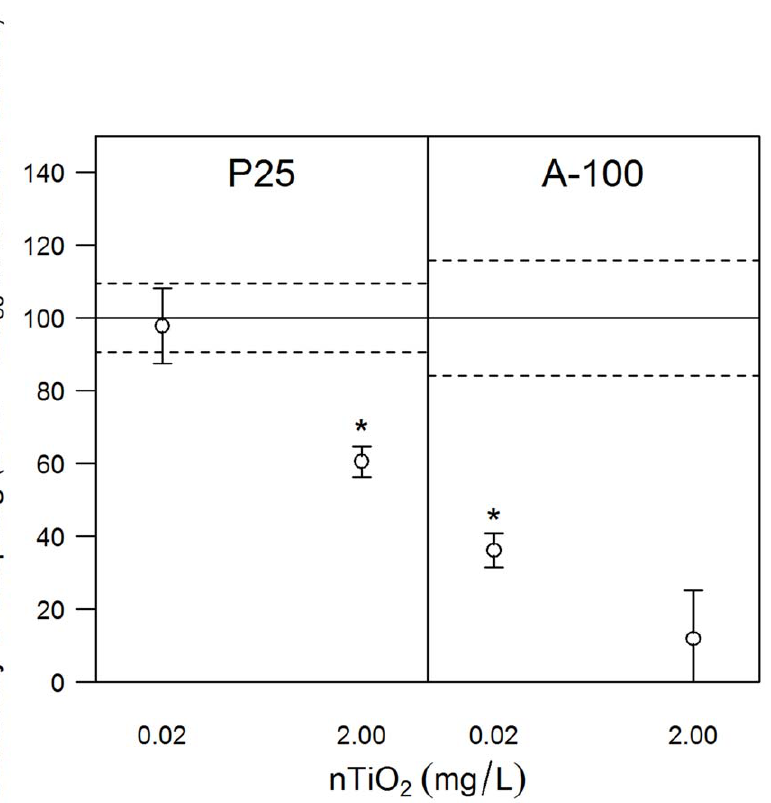
Figure 6. The sensitivity of juveniles released by adults exposed to different nTiO 2 products. Sensitivity, displayed as percent relative to the 96 h-EC 50 of the respective control, of the fifth brood released by adult D. magna exposed to different nTiO 2 treatments using the products P25 or A-100. The data displayed for P25 represent the weighted mean values of the seven experiments (first and second set of experiments), each with four replicates per treatment, whereas the 96 h-EC 50 for the offspring released from the control parents was 3.13 mg/L nTiO 2 . For the product A-100, the results of one experiment with four replicates of pre-treatment are displayed (fourth set of experiments). In this situation, the 96 h-EC 50 for the offspring released from the control parents was 1.98 mg/L nTiO 2 . The error bars and dashed lines indicate the standard error. The dashed lines are related to the control. Asterisks (*) denote significant differences between a treatment and the respective control.